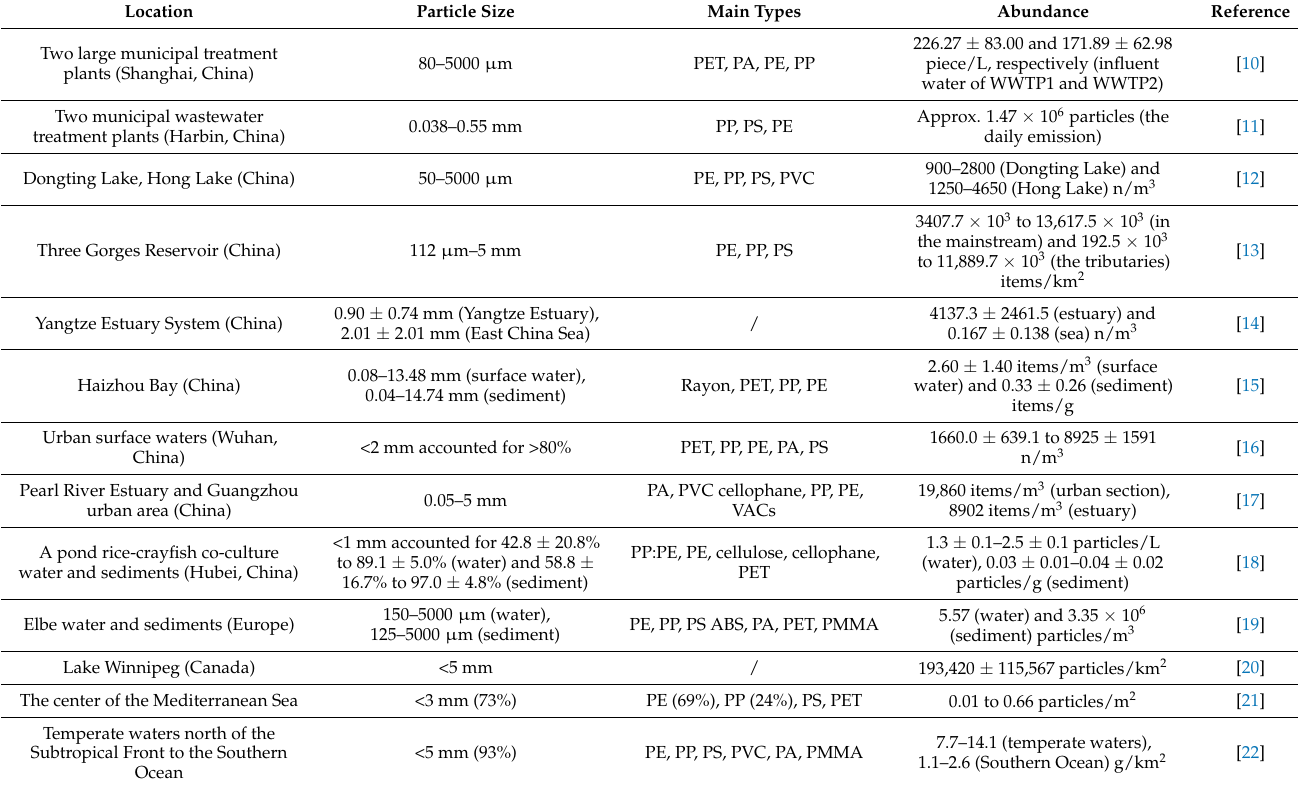
Table 1. The ubiquitous distribution of MPs as a stressor in global water